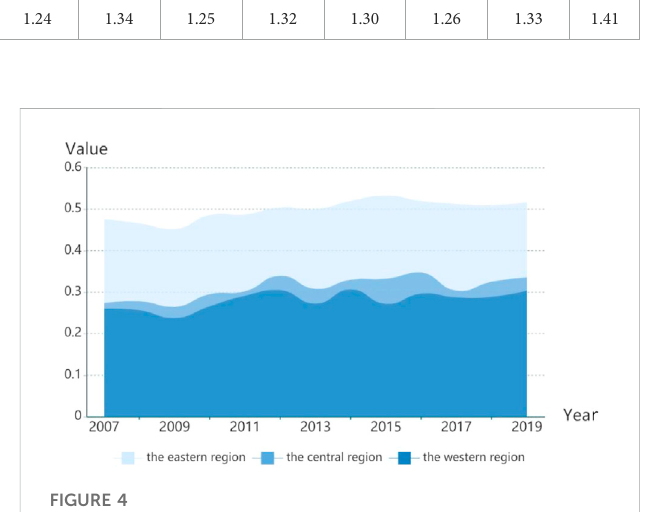
FIGURE 4 The DB environment scores of the three major regions in 2007 –